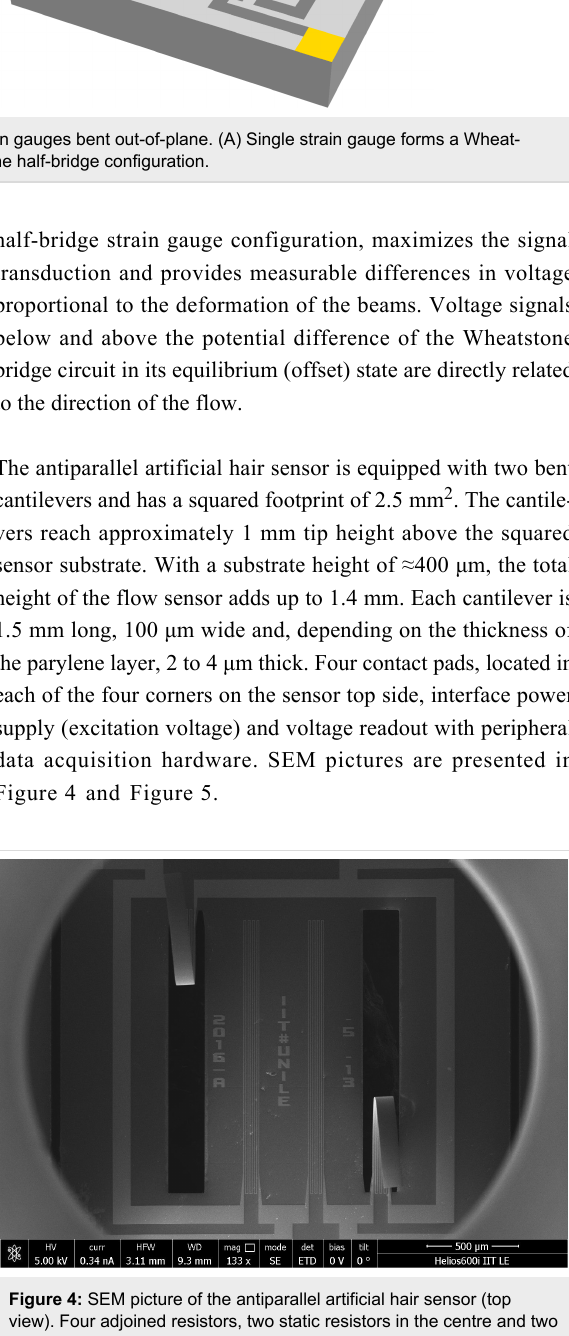
Flow velocities ranging between 10 m s − 1 and 32 m s − 1 were